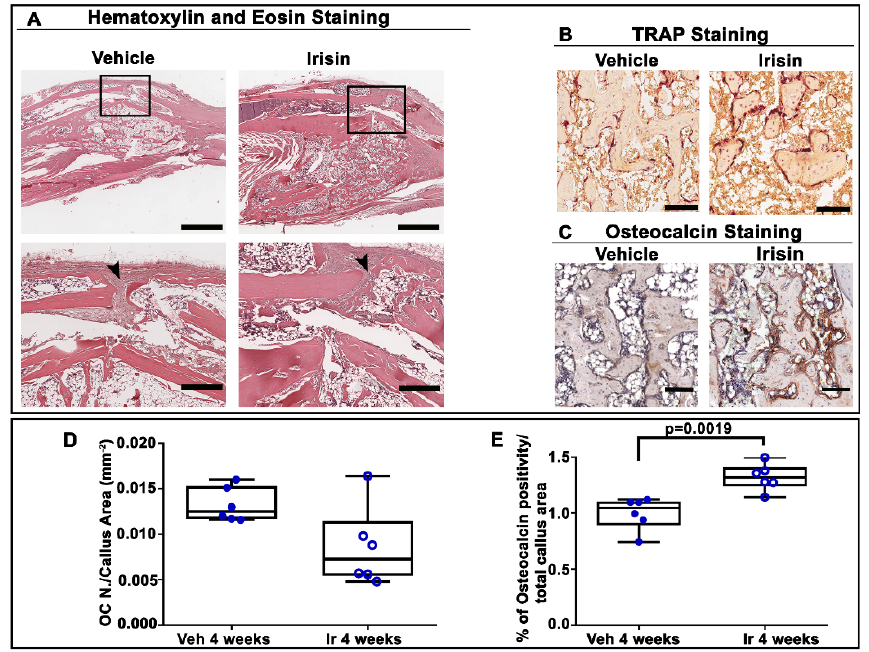
Figure 4. ( A ) Representative hematoxylin and eosin staining images on callus sections from vehicle- and irisin-treated mice at 28 days post-fracture (scale bar: 0.8 mm). The black squares indicate the area of higher magnification (scale bar: 60 µm). Arrowheads indicate the fibrous tissue. ( B ) Representative Trap staining images of callus sections from vehicle- and irisin-treated mice at 28 days post-fracture (scale bar: 30 µm). ( C ) Representative images of osteocalcin immunostaining in callus sections from vehicle- and irisin-treated mice at 28 days post-fracture (scale bar: 30 µm). ( D ) Quantification of OC N./CA in sections from vehicle- ( n = 6) and irisin-treated mice ( n = 6) at 28 days post-fracture. ( E ) Quantification of the percentage of osteocalcin-positive cells (osteocalcin + cell, %) out of all cells of the callus from vehicle-treated mice ( n = 6) and irisin-treated mice ( n = 6) at 28 days post-fracture. Data are presented as dot-plots with medians, from maximum to minimum, with all data points shown. The Mann–Whitney test was used to compare groups.